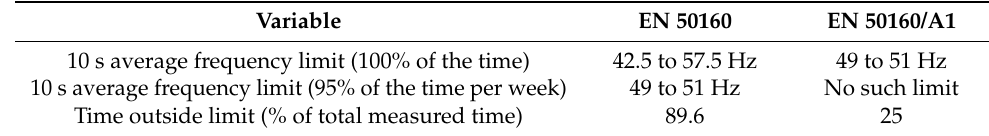
Table 1. Summary of Section 2.3 for the nanogrid during islanded operation.